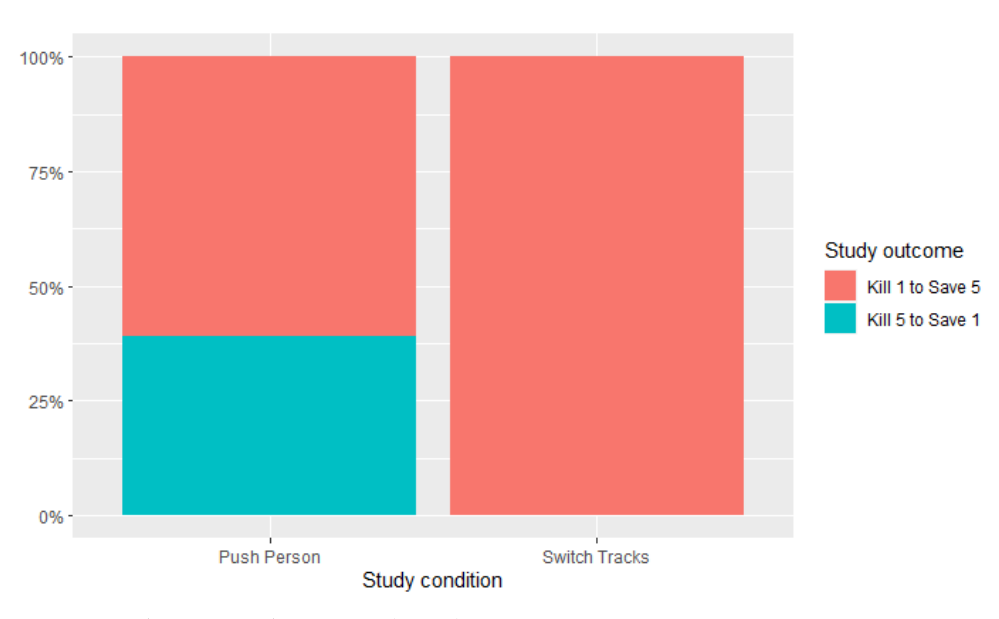
Figure 4. Study outcomes by scenario ( n =